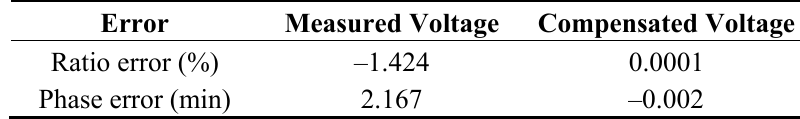
Figure 9. Results for Case 3: ( a ) v 1 (solid) and av 2 (dotted); ( b ) av s ; ( c ) i 0 (solid), i m (dotted), and i c (dashed); ( d ) i 1 (solid), i 0 (dotted), and i 2 /a (dashed); ( e ) v p ; and ( f ) v 1 (solid), av 2 (dotted), and v comp (dashed). Table 4. Errors for 80% of the rated